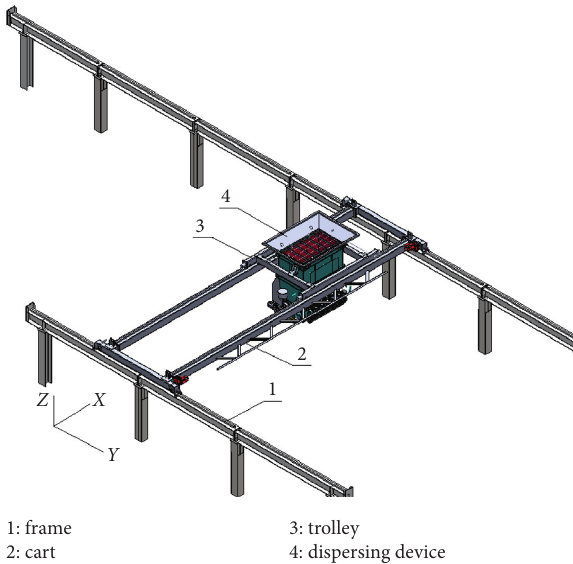
Figure 1: The structure of concrete spreader.